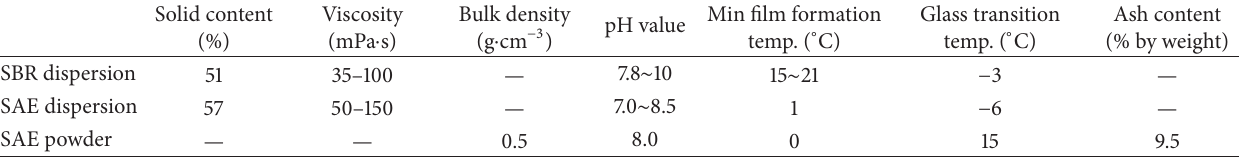
Table 2: The parameters of polymers.